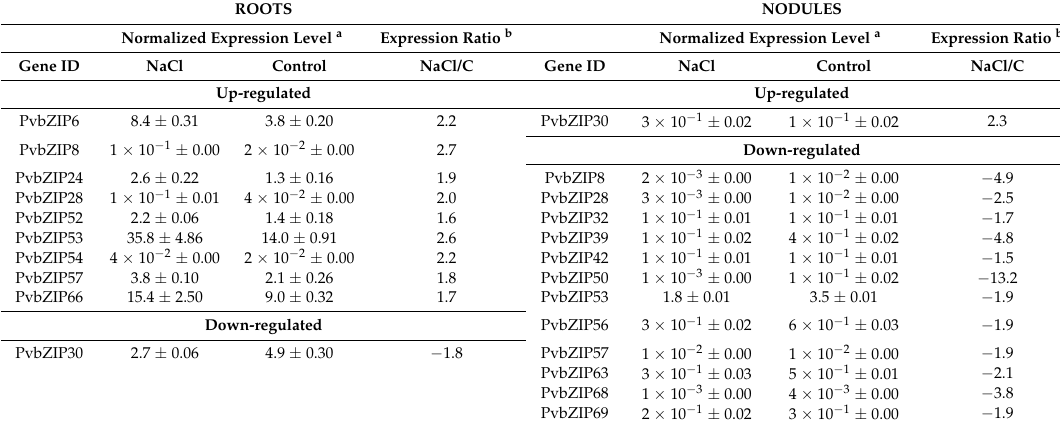
bZIP genes significantly differentially expressed ( ≥ 1.5-fold) in roots or nodules of NaCl-stressed symbiotic N 2 -fixation (SNF) plants identified by real-time RT-PCR. ROOTS